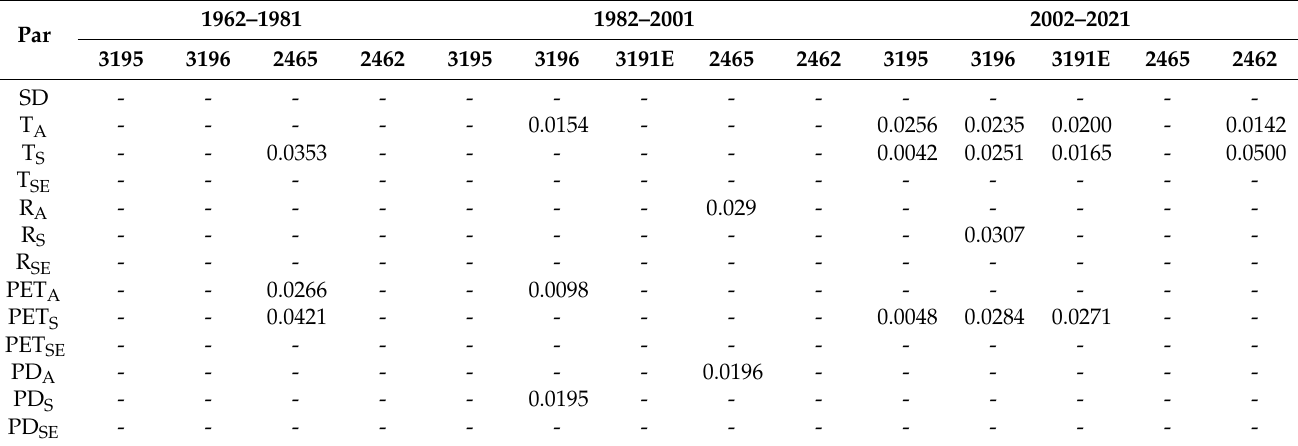
Table 5. Simple regressions for the stations and parameters analyzed for 20-year